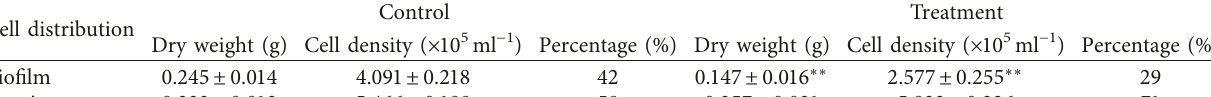
Table 1: Cell distributions in the floating phase and biofilm of diatom Stauroneis sp. incubated in the presence of bacterial supernatant crude extract.